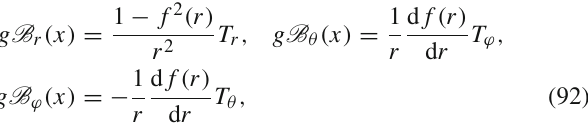
Figure 6 is the plot of the energy density e (ρ) as a function of ρ obtained from the solution a (ρ), f (ρ) and h (ρ) at C